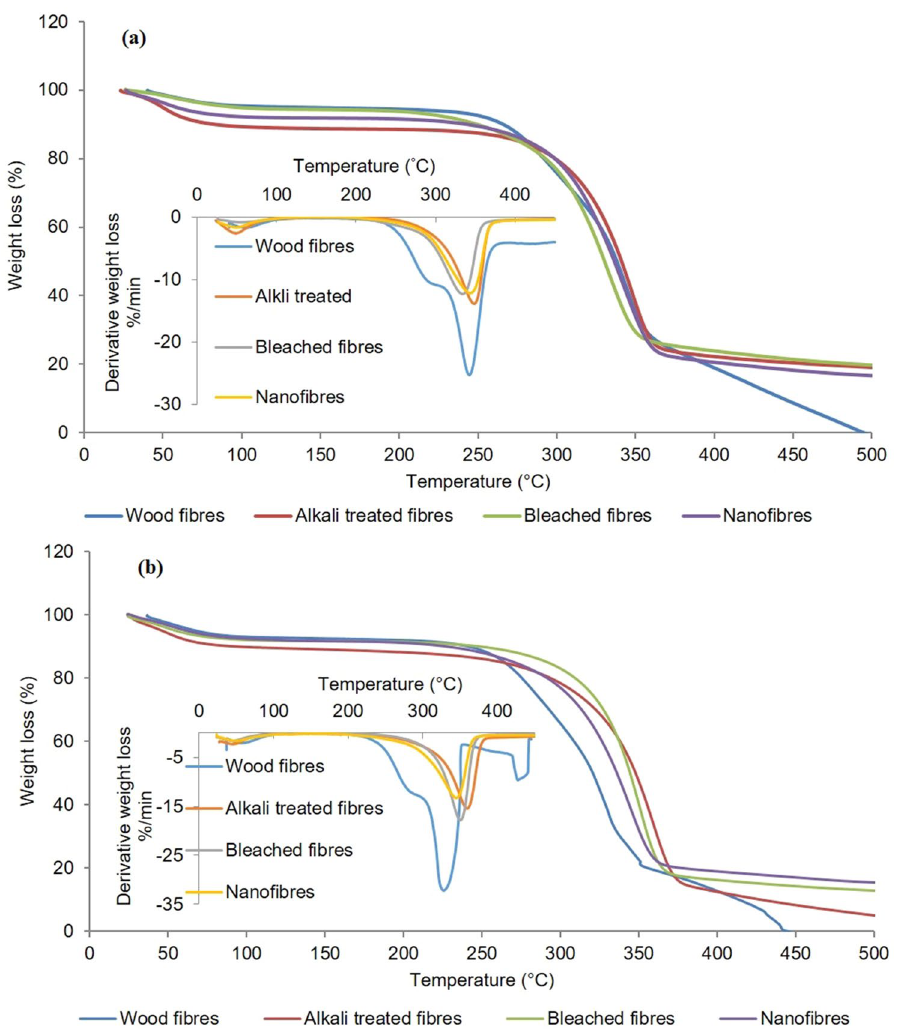
Figure 7. The per cent weight loss vs. temperature graph and DTG curve of untreated and treated samples of ( a ) Eucalyptus tereticornis and ( b ) Casuarina equisetifolia .